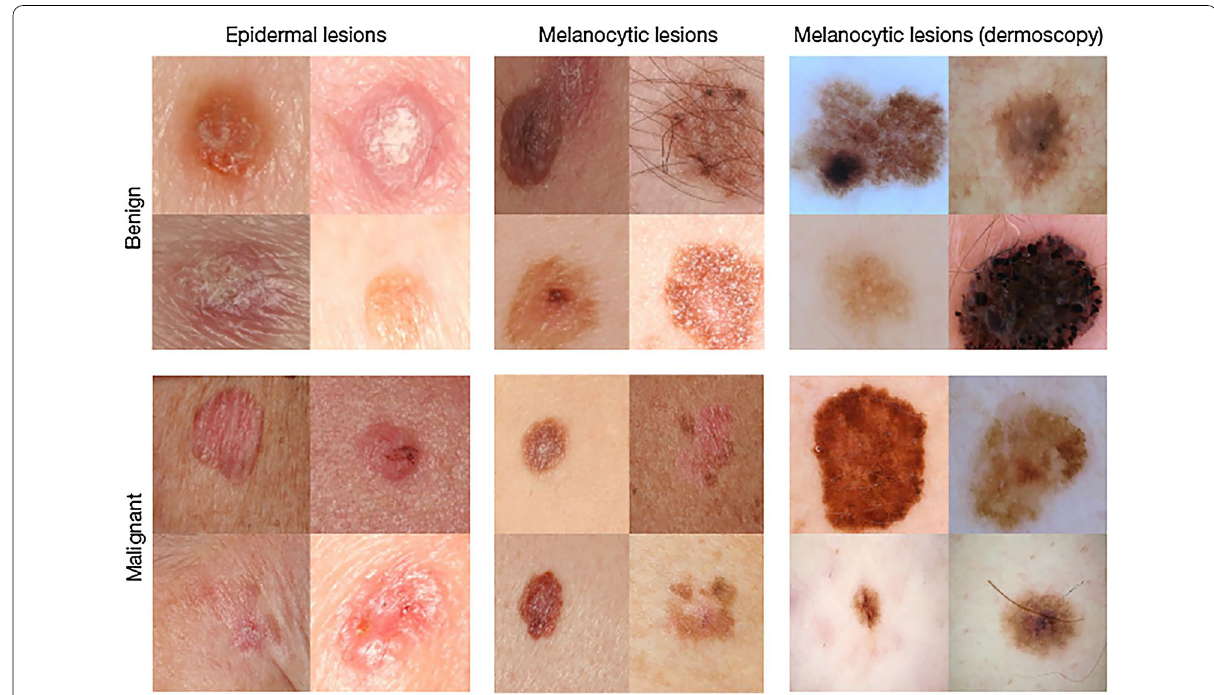
Figure 2 Malignant and benign sample images from two disease classes ( Reproduced with permission from Ref. [9] and credit (CC BY